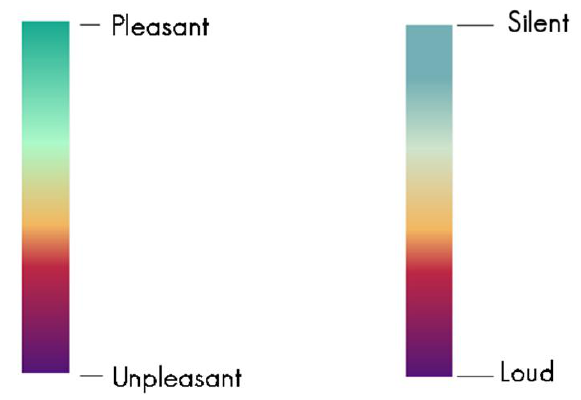
Figure 14: Final color scales for the loudness and the pleasantness of the sound